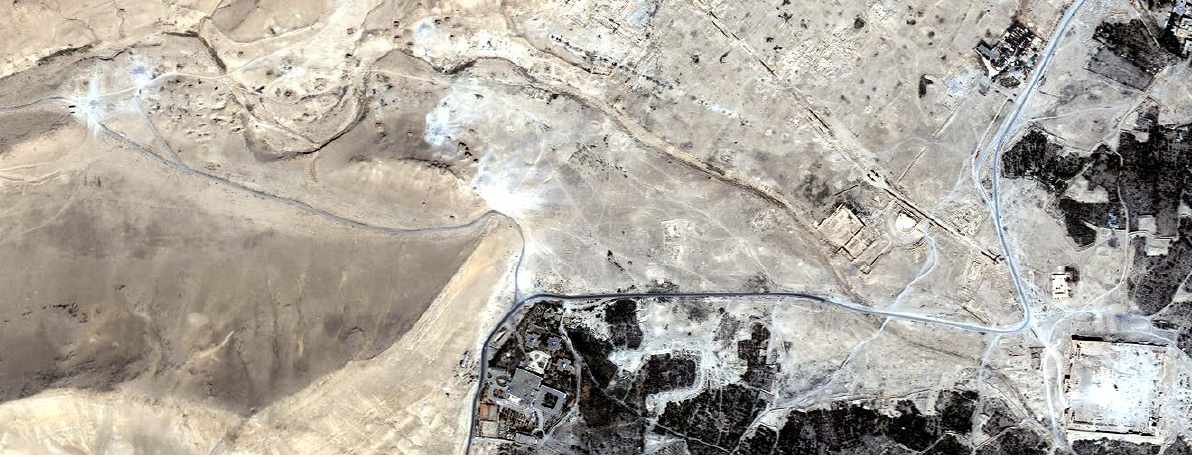
Figure 3. Subset of the WorldView-2 image acquired on the 2 nd of September 2015 (©European Space Imaging / DigitalGlobe).